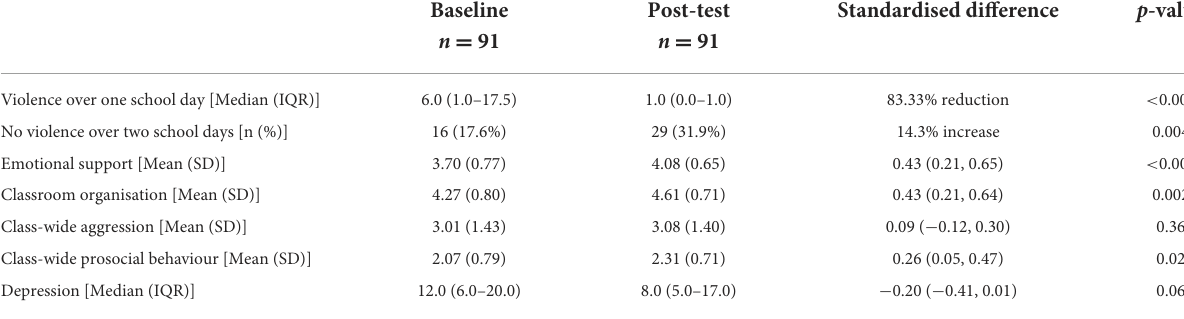
TABLE 4 Pre-test and post-test scores for outcome variables and standardised